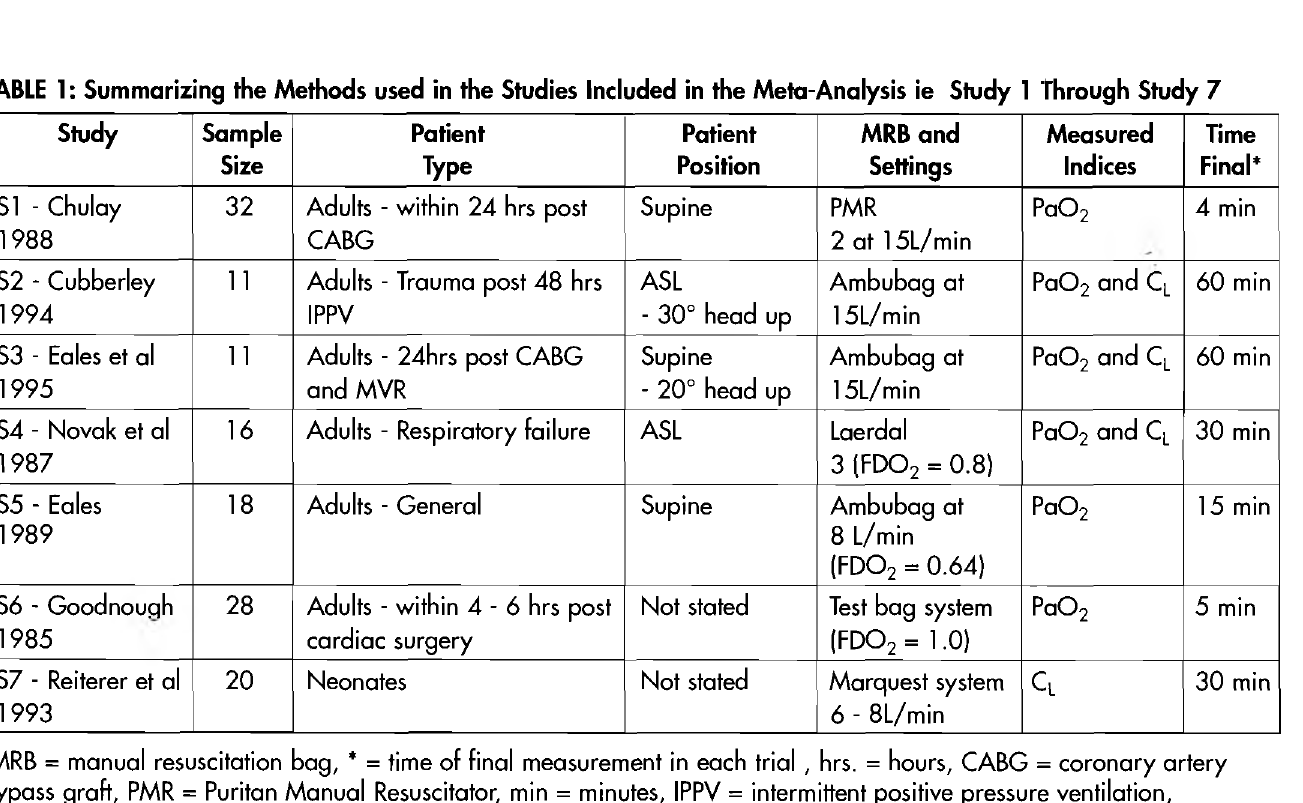
TABLE 2: Summarizing the Methods Used in the Studies Excluded from the Meta-Analysis